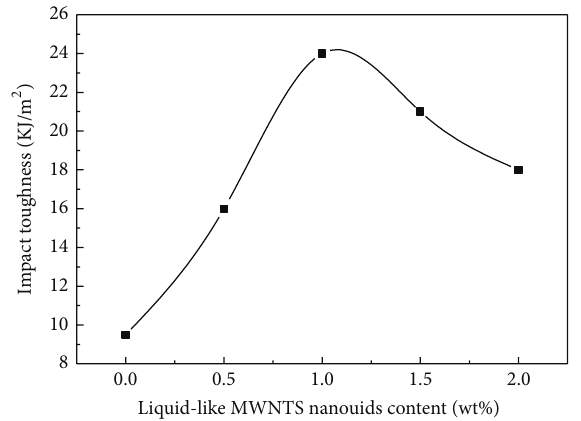
Figure 9: The effect of liquid-like MWNTs nanofluids content on the impact toughness of nanocomposites.